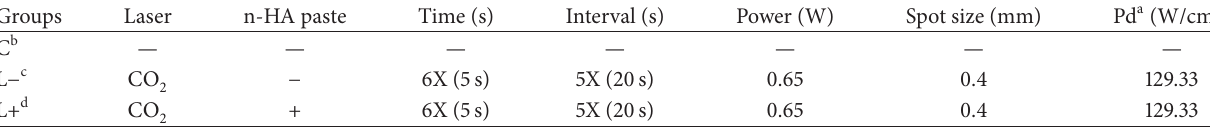
Table 1: Sample grouping and treatment.